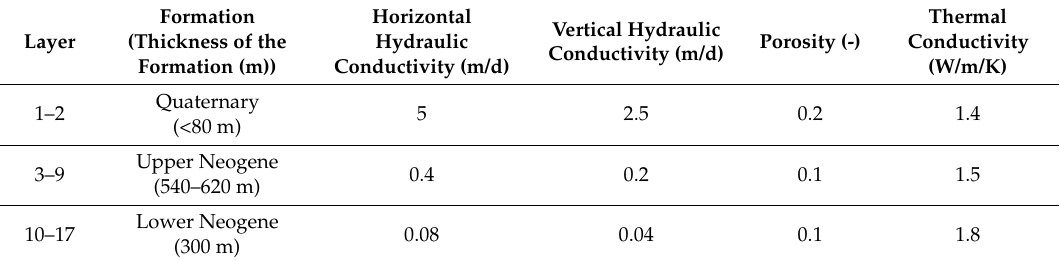
Figure 2. 3D groundwater flow and heat transport model of the Sendai Plain. Table 1. Input parameters of the regional model of the Sendai